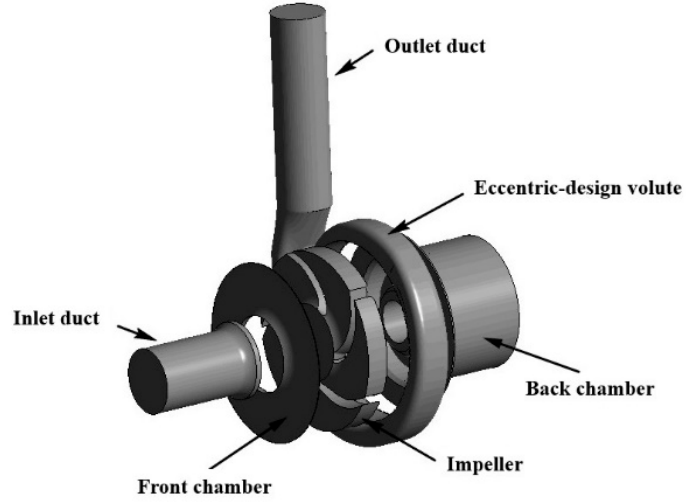
Figure 1. Geometry of the miniature centrifugal pump. Table 1. Parameters of the miniature centrifugal pump.